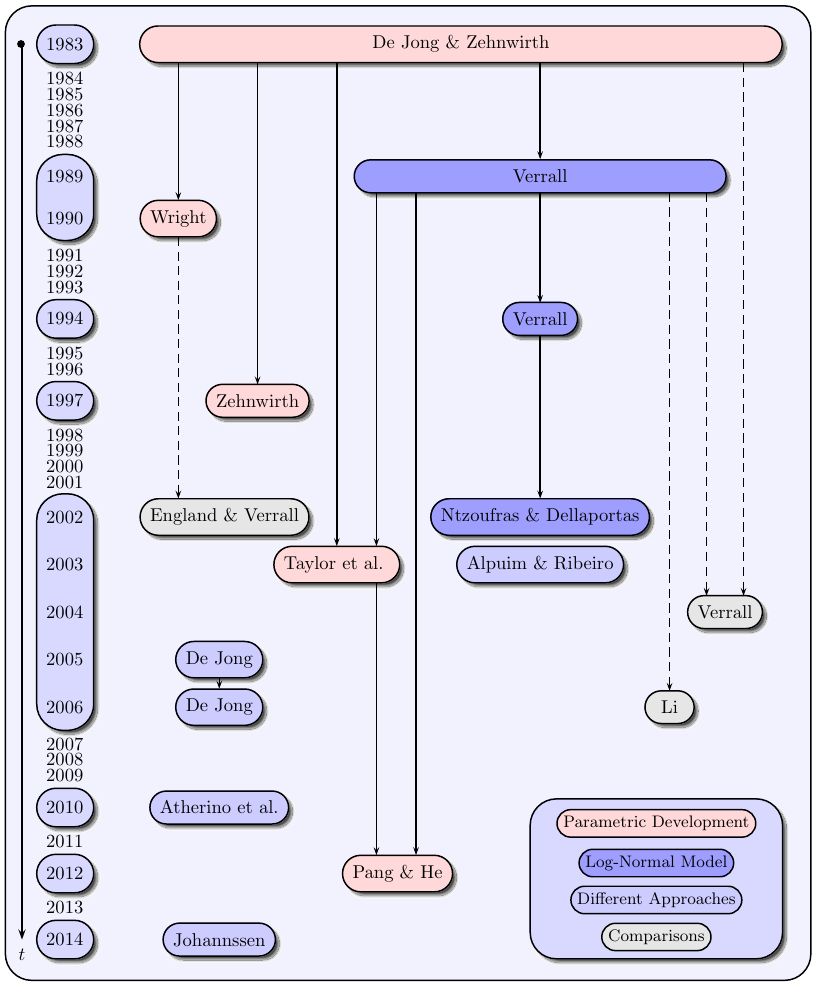
Figure 1. Chronology and categorization of the papers based on state space